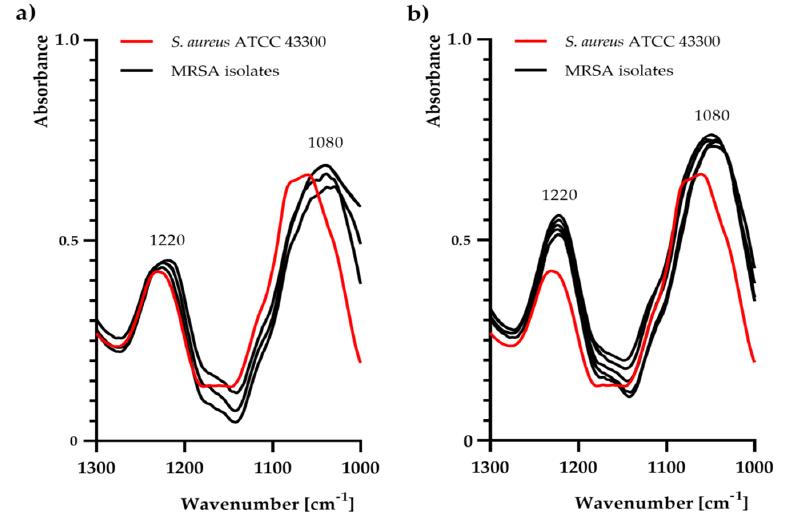
methicillin-resistant S. aureus (MRSA) isolates.